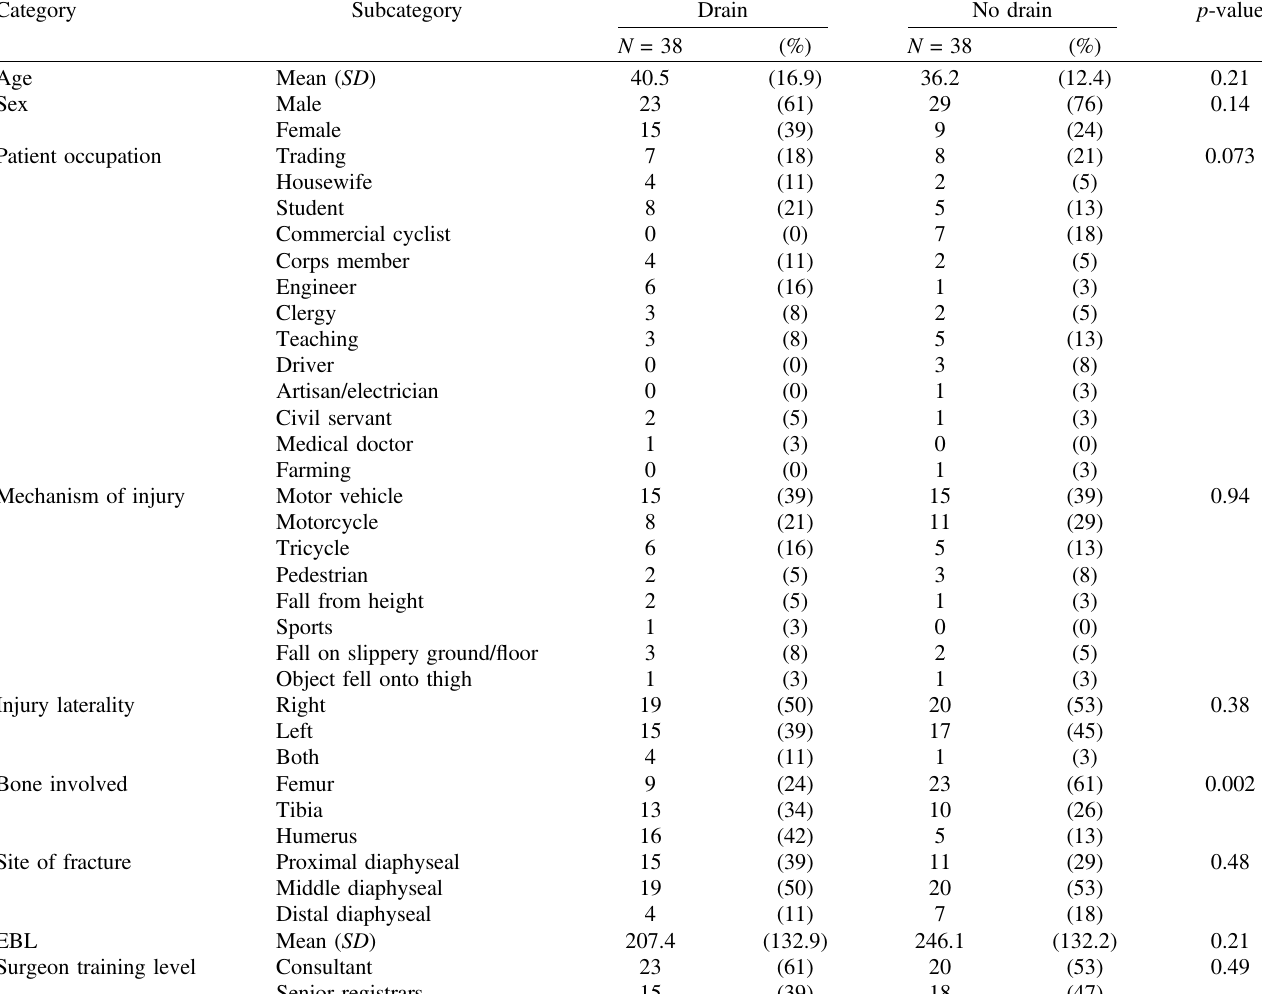
Table 1. Patient demographics and peri-operative characteristics. Category